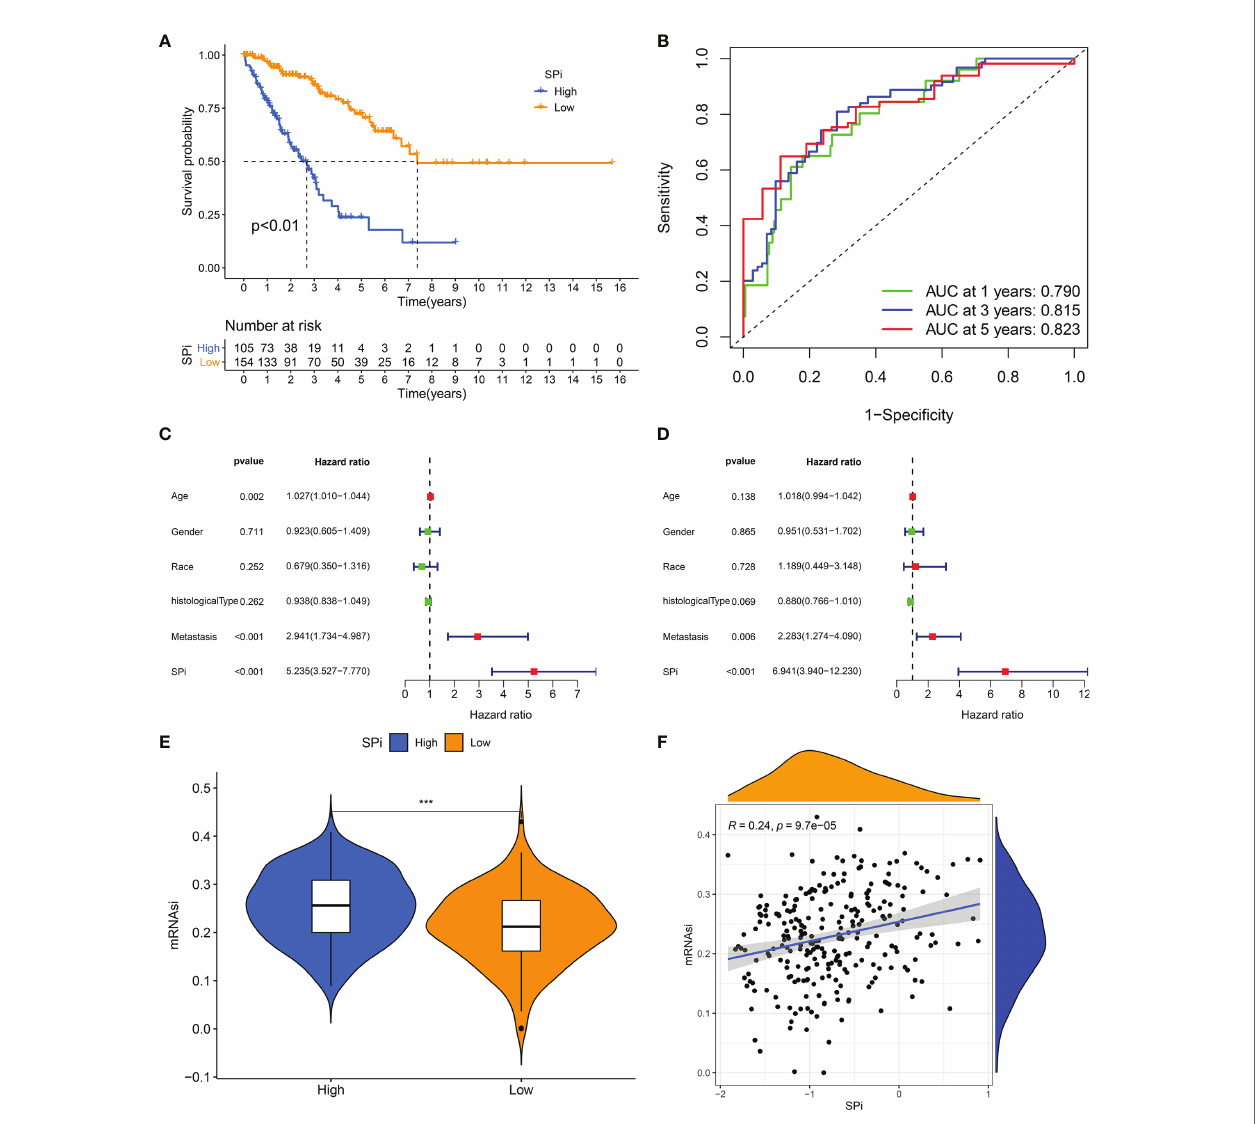
FIGURE 6 | The prognostic role and stemness characteristic of SPi in STS from TCGA cohort. (A) K – M survival analysis of patients with high and low SPi. (B) ROC curve of SPi at 1, 3, and 5 years. Forest plot of the univariate (C) and multivariate (D) analyses for the clinical factors and SPi in STS. (E) The difference of mRNAsi between high-SPi patients and low-SPi patients. (F) The correlation of SPi with mRNAsi. ***p <